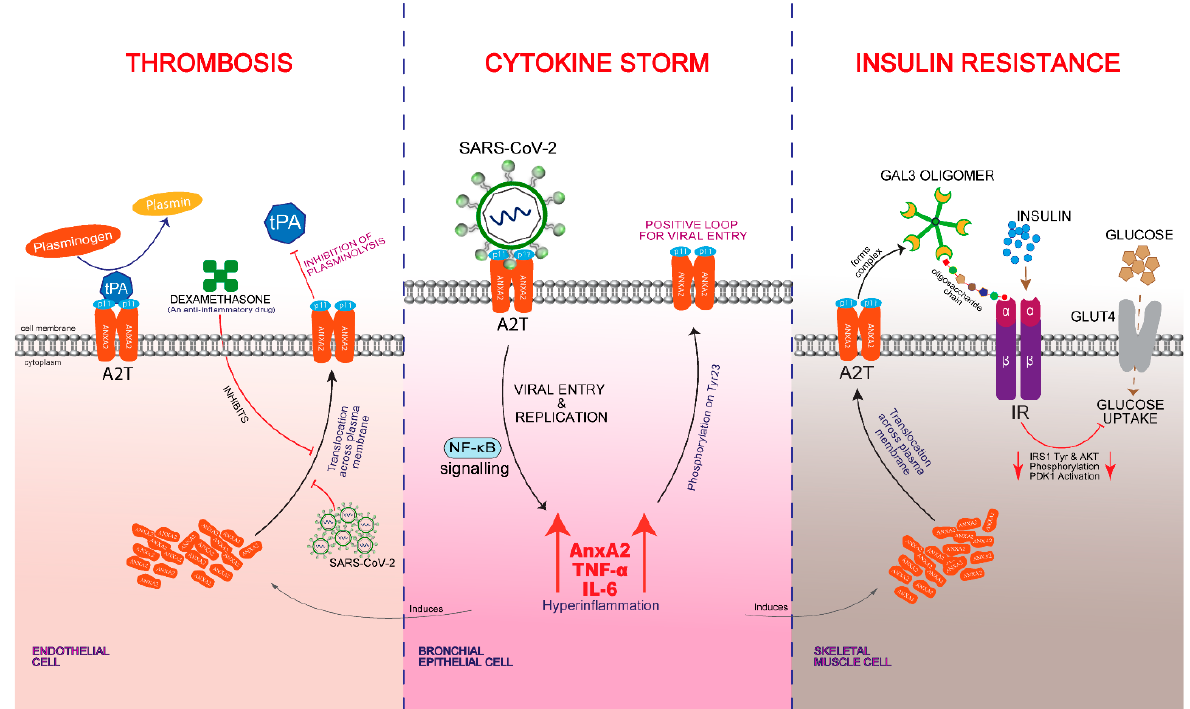
Figure 3. The proposed model for the pathophysiological involvement of human AnxA2 interaction with SARS-CoV-2 spike glycoprotein S2 at the membrane surface. Upon host cell infection, virus induces the production of AnxA2 and utilizes it for internalization and replication, triggering an aggressive immune response that results in the release of a large amount of pro-inflammatory cytokines including autocrine AnxA2, and IL-6, IL-1 β , and TNF- α , resulting in a cytokine storm. In severe COVID-19 patients, an apparent hypofibrinolysis has been observed, which could be related to the ceaseless engagement of AnxA2 with viral replication, rendering it unavailable for its typical function of tPA mediated conversion of plasminogen to plasmin, a major participant in fibrinolysis. In addition, a methylprednisolone or dexamethasone, an anti-inflammatory or immunosuppressant drug given to hospitalized COVID-19 patients with pneumonia, induces anti-inflammatory AnxA1 and recruits it to the cell membrane, resulting in decreased membrane deposition of AnxA2 that could further impede the plasminolysis. Furthermore, the glycosylated AnxA2 at the membrane surface interacts with galectin-3 that can bind directly to the insulin receptor and blocks its activation and inhibits down-stream signaling such as IRS1 tyrosine phosphorylation, PDK1 activation, and AKT phosphorylation. Subsequently, it leads to the inhibition of insulin-dependent glucose uptake and translocation of GLUT4, resulting in hyperglycemia. ACE2, Angiotensin converting enzyme 2; AKT, Protein kinase B; AnxA2, Annexin A2; A2T, Annexin A2 Tetramer; GAL3, Galectin-3; GLUT4, Glucose transporter type 4; IL-6, Interleukin 6; IR, Insulin receptor; IRS1, Insulin receptor substrate 1; NF- κ B, Nuclear factor kappa B; p11, Protein S100A10; PDK1, Pyruvate dehydrogenase kinase 1; TNF α , Tumor necrosis factor alpha; and tPA, Tissue plasminogen